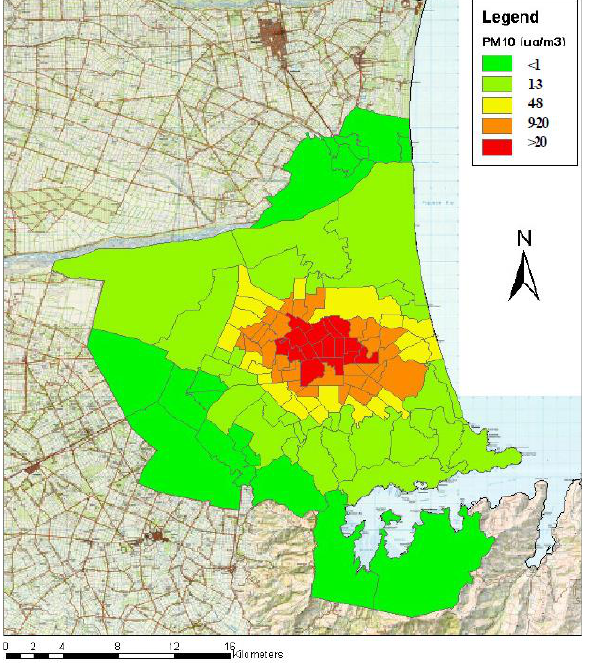
Figure 2. Annual PM 10 exposure map of Christchurch in 2005 (Fisher et al., 2005)